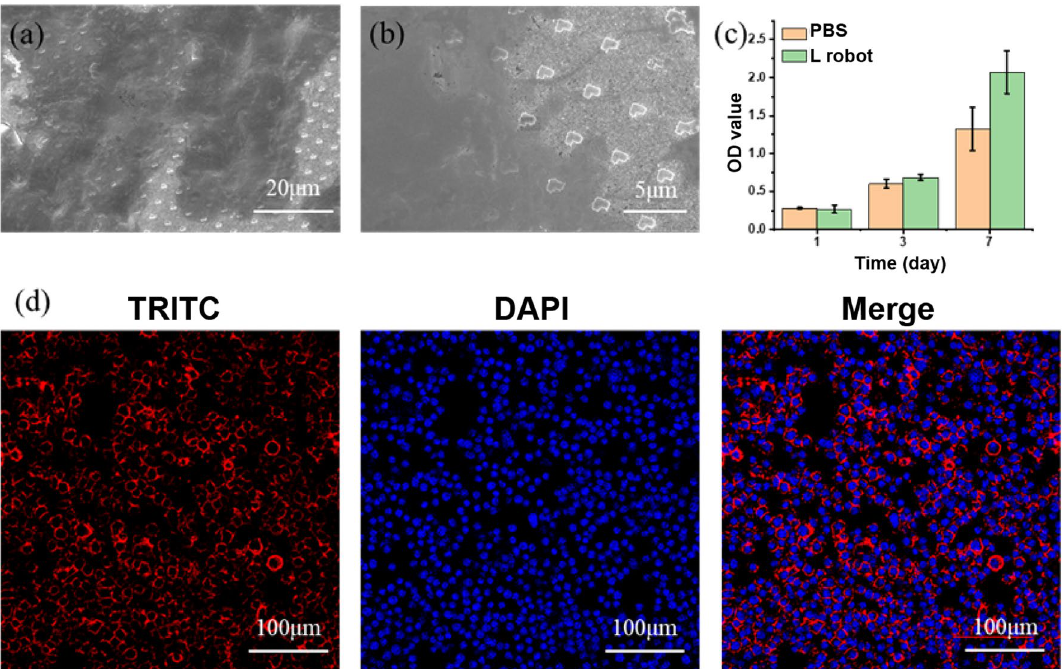
Figure 6. Cell cytotoxicitys with RAW264.7 immune cells. SEM image ( a ) and a zoom-in view ( b ) of L-shaped robot cultured with RAW264.7 immune cells. ( c ) Cell viability test using CCK-8 assay. ( d ) Immunofluorescence staining, nuclei were stained with DAPI (blue), and F-actin was stained with TRITC-phalloidin